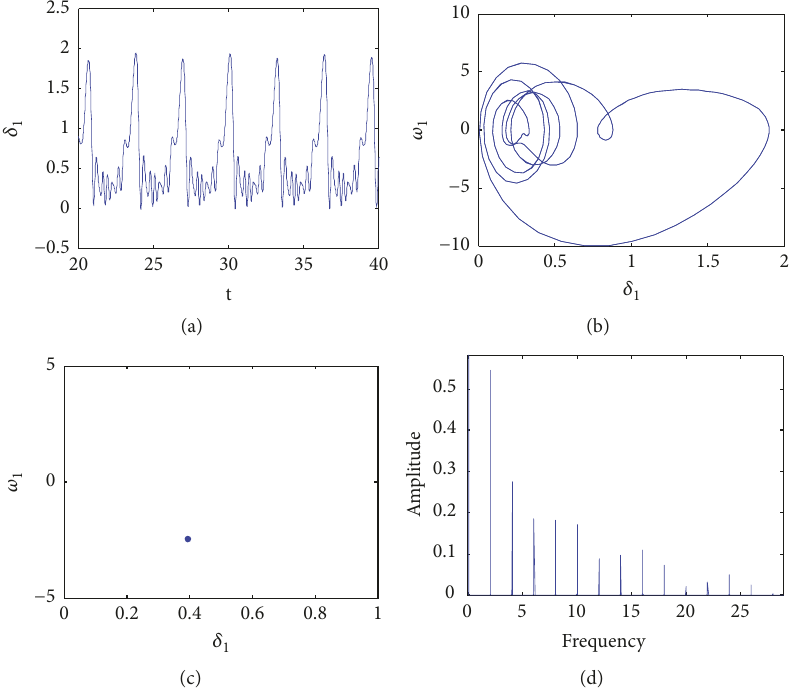
Figure 5: Period 1 motion ( 𝑉 𝐵1 = 0.63 ). (a) Time history. (b) Phase portrait. (c) Poincar´e map. (d) Frequency